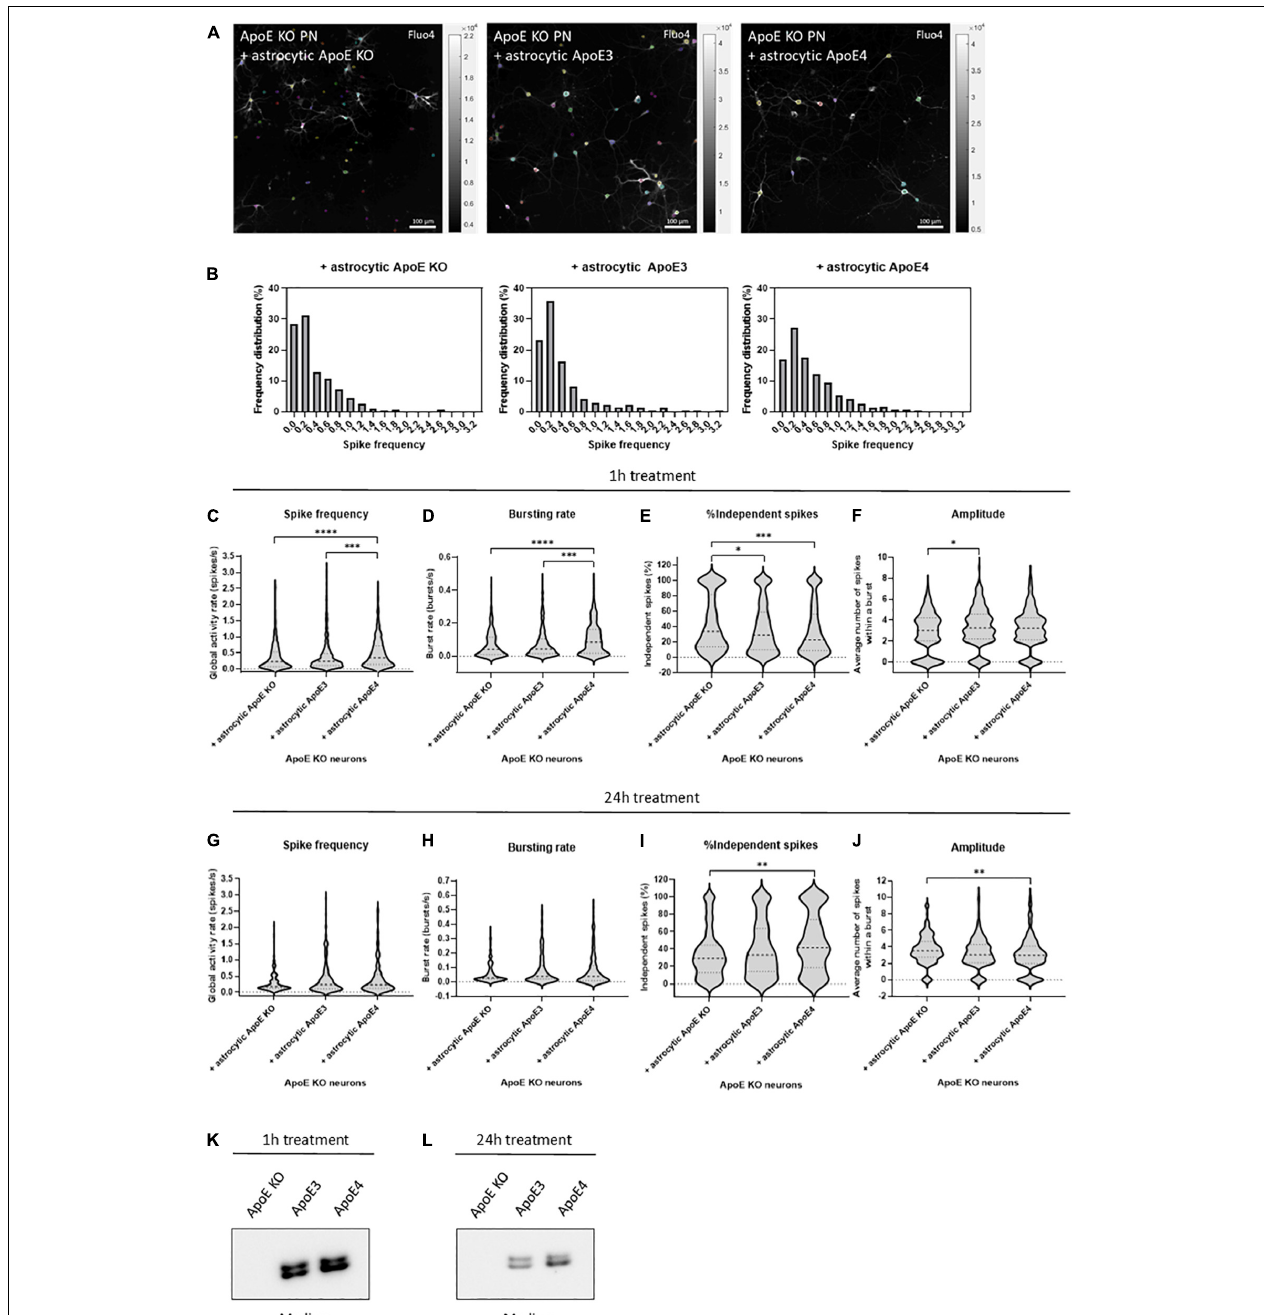
FIGURE 2 | Astrocytic ApoE4 increases neuronal activity after treatment for 1 h, but not 24 h in ApoE KO primary neurons. (A) Representative images of ApoE KO neurons treated with astrocytic ApoE KO, ApoE3 or ApoE4 for 1 h (18–20 DIV) obtained by live cell Ca 2 + imaging. The neurons were labeled for Fluo4 (white), a Ca 2 + indicator. Each colored circle represents one region of interest (ROI). The scale bar represents 100 µ m. (B) Representative frequency distribution plots of ApoE KO neurons cultured with ApoE KO, ApoE3 or ApoE4 astrocyte conditioned medium for 1 h. (C–F) Quantifications of spike frequency (C) , bursting rate (D) , percentages of independent spikes within a culture (E) , and amplitude (F) of ApoE KO neurons treated with ApoE KO, ApoE3 or ApoE4 astrocyte conditioned medium for 1 h analyzed using NETCAL program ( N ApoEKO = 12 embryos, N ApoE 3 = 13 embryos, N ApoE 4 = 14 embryos; n ApoEKO = 291 neurons, n ApoE 3 = 414 neurons, n ApoE 4 = 426 neurons). (G–J) Quantification of spike frequency (G) , bursting rate (H) , percentage of independent spikes within a neuronal culture (I) , and amplitude (J) of ApoE KO, ApoE3 or ApoE4-medium treated ApoE KO neurons for 24 h ( N ApoEKO = 6 embryos, N ApoE 3 = 6 embryos, N ApoE 4 = 6 embryos; n ApoEKO = 157 neurons, n ApoE 3 = 173 neurons, n ApoE 4 = 126 neurons). (K,L) Representative Western blot analysis of human ApoE proteins in neuronal medium of ApoE KO neurons treated with astrocytic ApoE KO, human ApoE3 or human ApoE4 medium for 1 h (K) or 24 h (L) . Data are expressed as violin plots. Kruskal Wallis tests in combination with Dunn’s multiple comparison tests were performed to detect statistical differences. * p < 0.05; ** p < 0.01; *** p < 0.001; **** p < 0.0001.